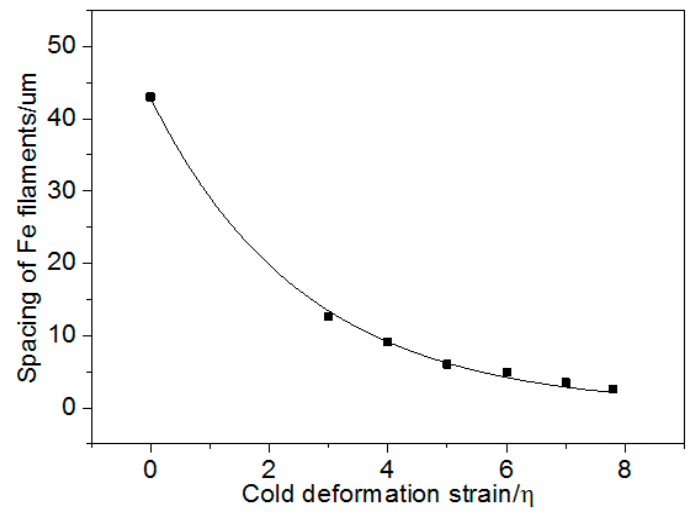
Figure 5. Spacing of the Fe phase in the Cu–14Fe vs. the cold deformation strain.